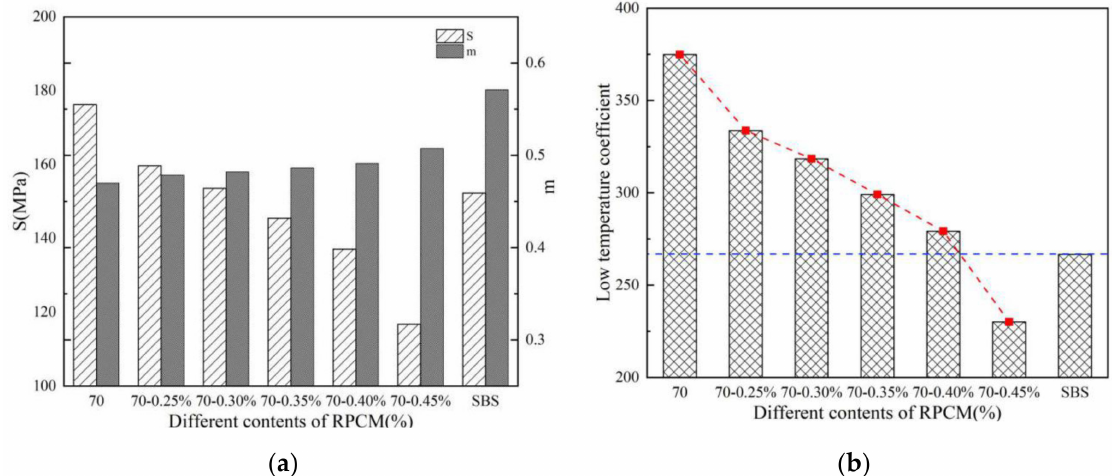
Figure 8. ( a ) Creep stiffness; (S) m value; ( b ) low-temperature